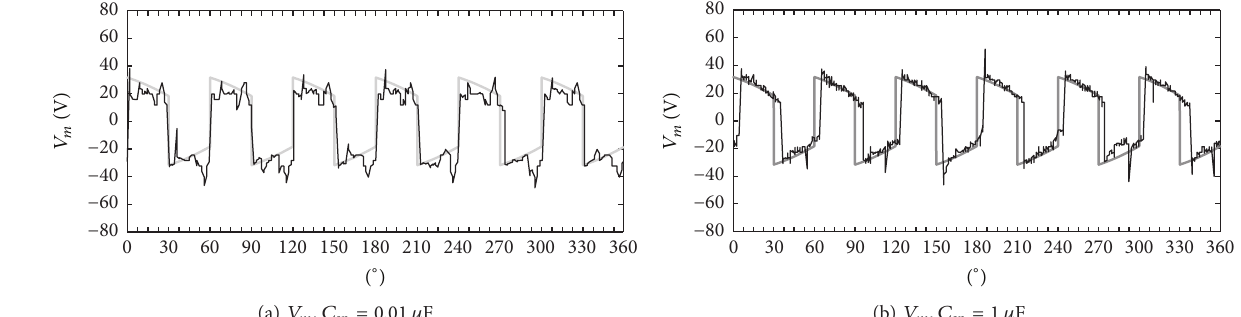
Figure 31: Reinjection transformer secondary side voltage 𝑉 𝑚